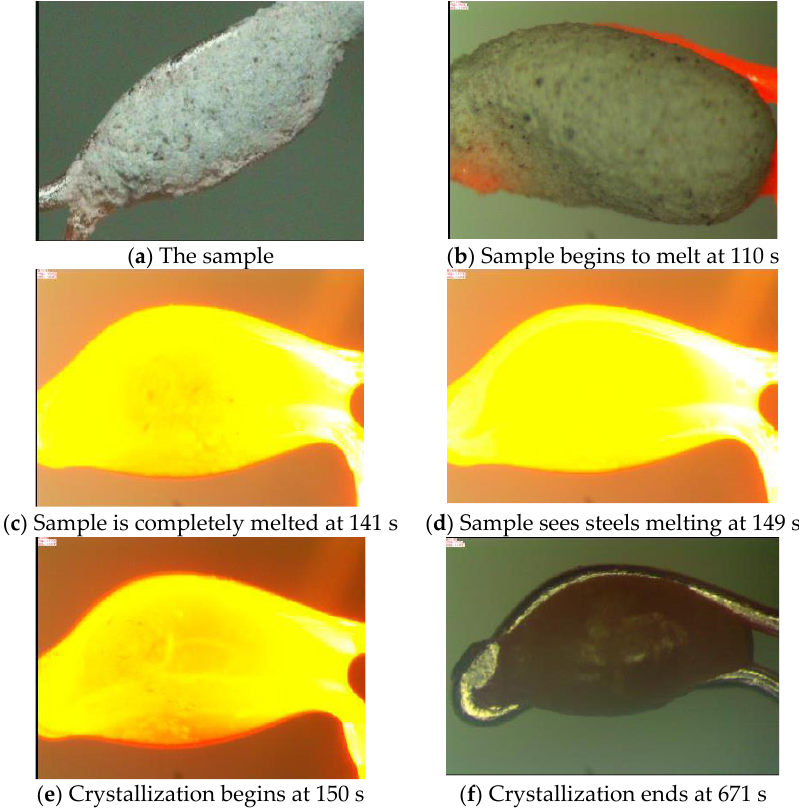
Figure 2. Melting and crystallization images of mold fluxes at different times.